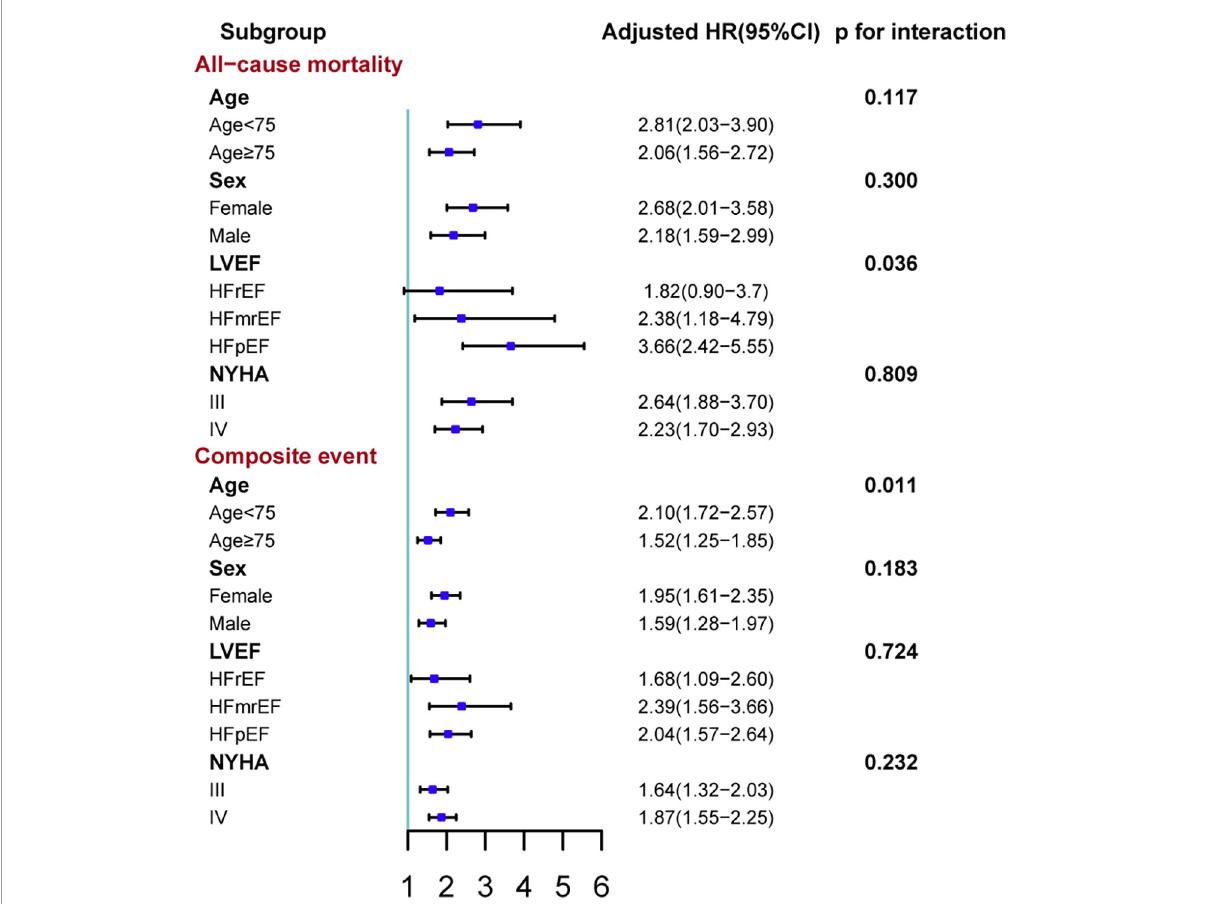
FIGURE4 Subgroup analyses of the association between depression and adverse outcomes stratified by age, sex, in-hospital ejection fraction, and NYHA class. The composite event was time to death or HF rehospitalization. Adjusted variables in the Cox proportional hazard model: age, sex, body mass index, systolic blood pressure, left ventricular ejection fraction, current smoker, diabetes, chronic obstructive pulmonary disease, coronary heart disease, anemia, estimated glomerular filtration rate, serum sodium concentration, New York Heart Association class, and the use of renin-angiotensin system inhibitors, β -blockers, mineralocorticoid receptor antagonists and statin at discharge, and hospital levels. Anemia was defined as hemoglobin < 13 g/dl in male patient or hemoglobin < 12 g/dl in female patient. HFrEF, heart failure with decreased ejection fraction; HFmrEF, heart failure with mildly reduced ejection fraction; HFpEF, heart failure with preserved ejection fraction. HR, hazard ratio; CI: confidence